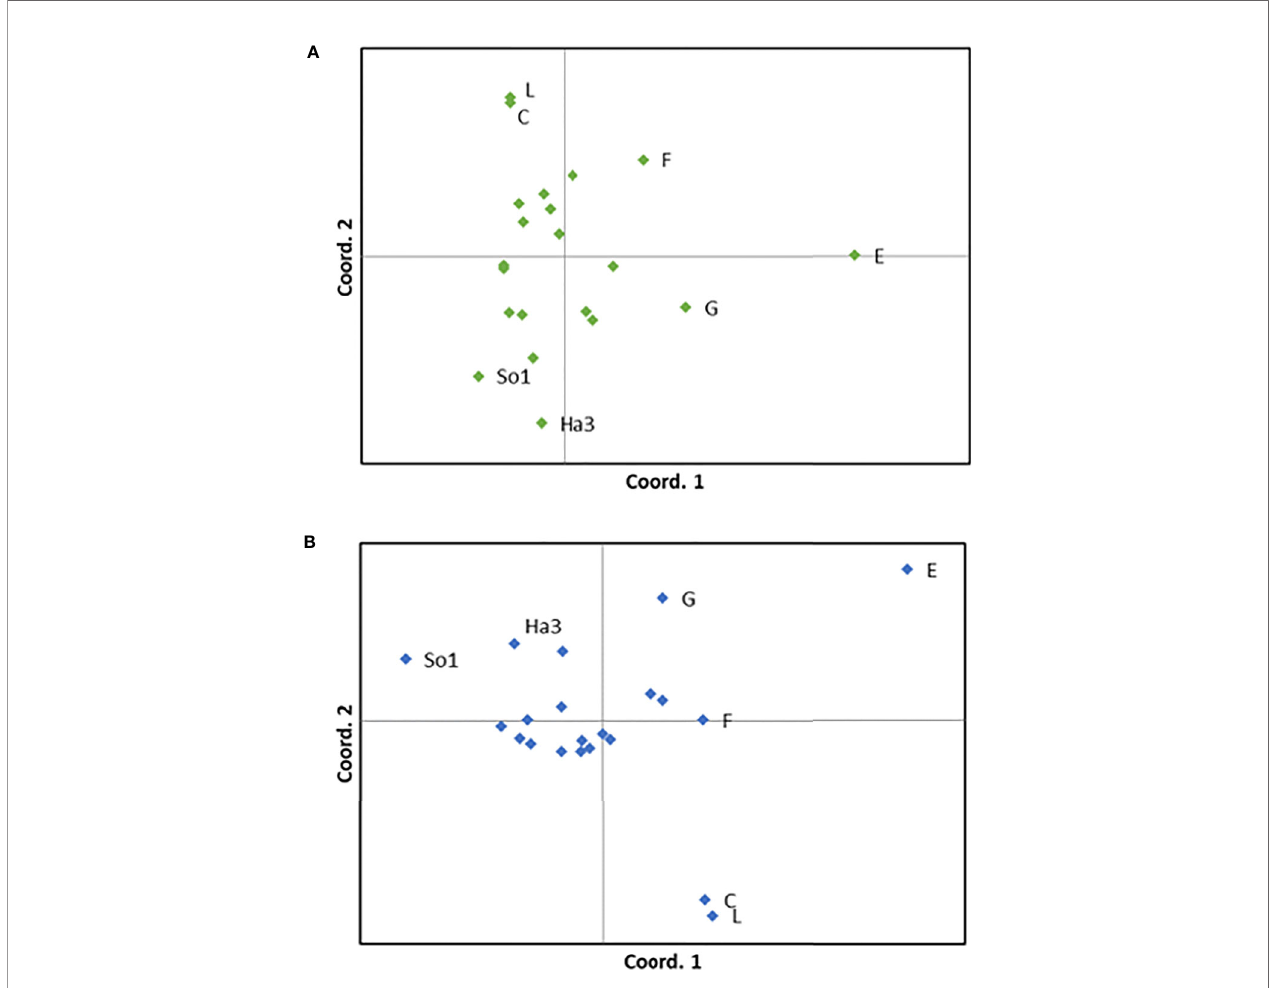
FIGURE 3 | Results from PCoA (Principal Coordinates Analysis), where each dot represents one sampling station. (A) Plot with 8 loci, (B) Plot with 9 loci (i.e. the locus putatively under positive selection (SLN 35) is included). The two stations in Skagerrak (L and C), the three northernmost stations (G, F, E) and the two fjord stations which differs most from the other stations (SO1 in Sognefjord and HA3 in Hardangerfjord) are